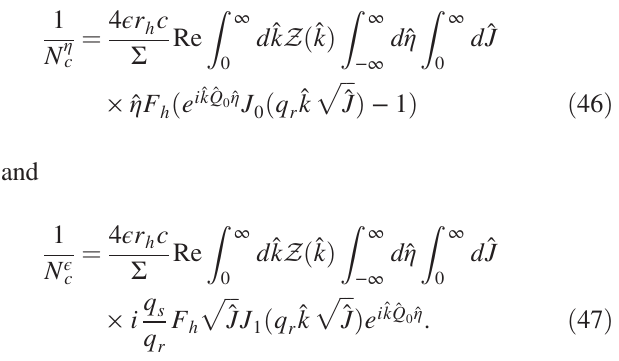
ffiffiffi p (cid:8)(cid:8) ˆ J